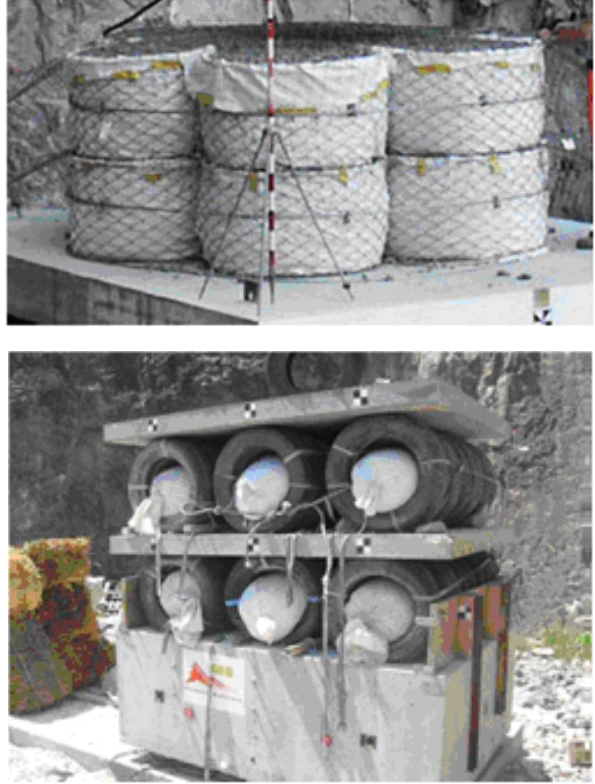
Fig. 14. Alternative cushion layers: (top) Fence box structure with cellular glass material (Schellenberg, 2008), (bottom) Multi-layer sandwich structure (Lorentz et al.,